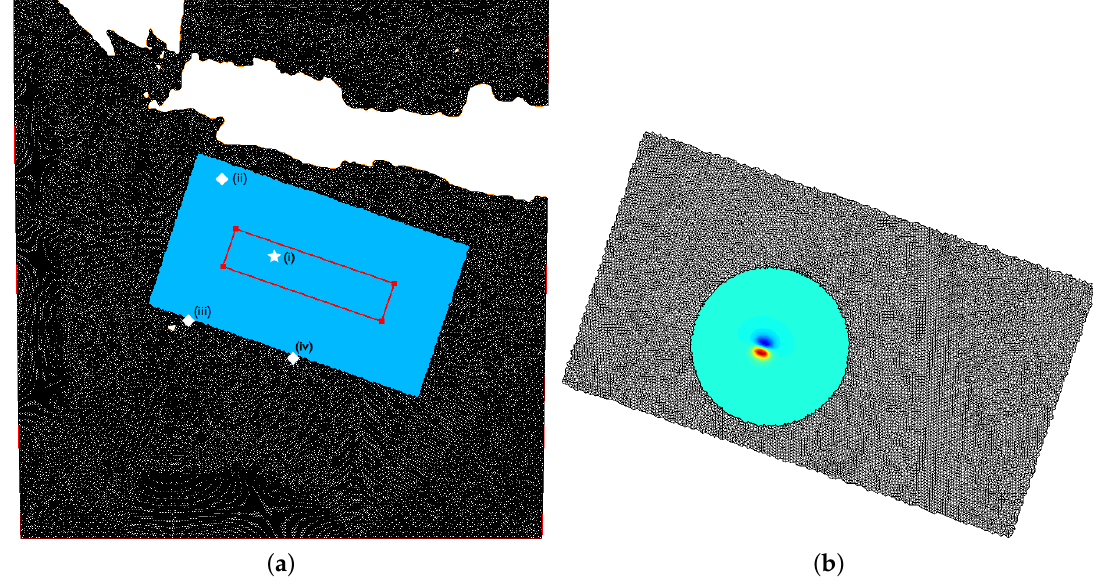
Figure 6. Left panel ( a ): Surface projection of the fault’s plane and the mesh around, (cid:5) : wave gauge, (cid:63) : epicenter. Right panel ( b ): the 14-th Okada solution (min = − 0.09 m, max = 0.17 m